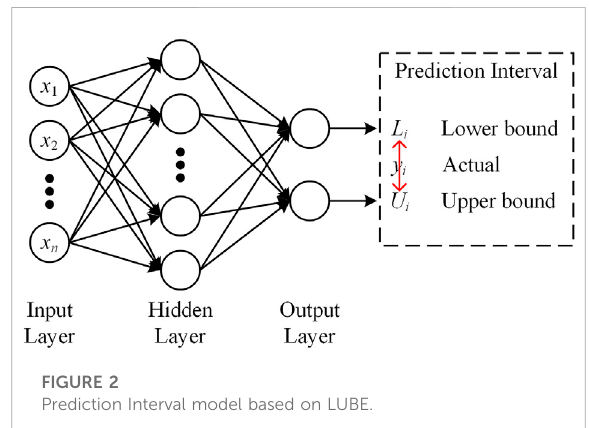
FIGURE 2 Prediction Interval model based on